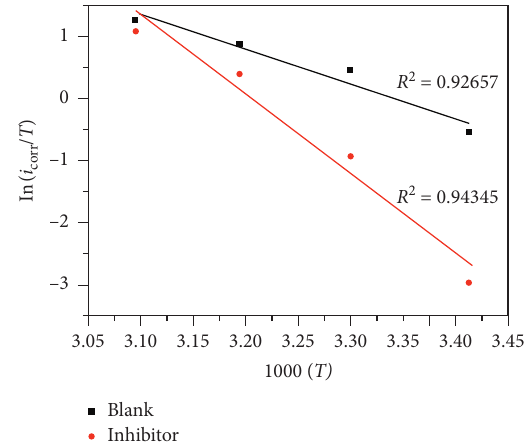
Figure 6: Transition-state plots for SS in 1M H and presence of 10 − 3 M of